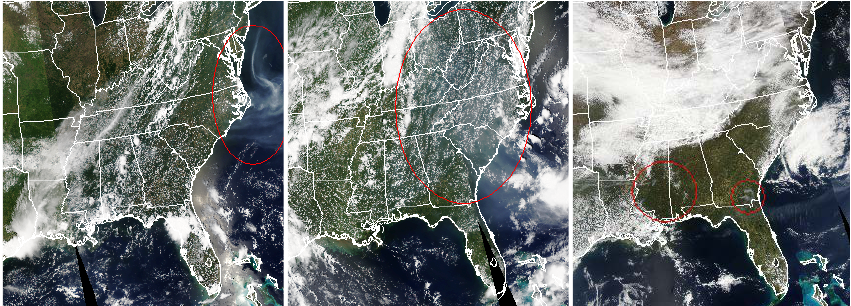
Figure 1 Fig. 1. MODIS Aqua imagery shows smoke from the Evans Road fire in North Carolina on 10 June 2008 (left), haze in Ohio Valley and Southeast on 8 July 2010 (middle), and agricultural fires and wildfires in Louisiana, Mississippi, Alabama, Georgia, and Florida on 25 March 2011 (right). The areas covered by plumes are shown as the red ovals. The imagery is available from http://www.star.nesdis.noaa.